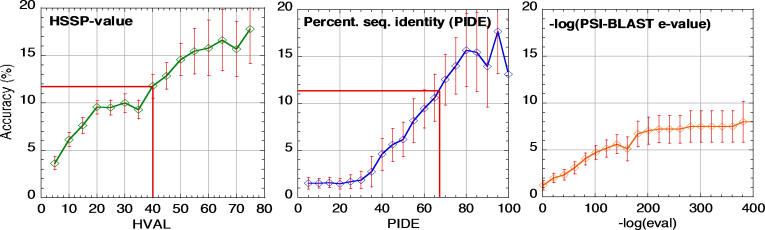
Sequence Conservation of PPIsThe performance of homology transfer was evaluated with the data sets in Experiment 1 (Table 4). Each panel plots the conservation (accuracy of homology transfer) using a different measure for sequence similarity: HVAL (Equation 1), PIDE (percentage pairwise sequence identity), and the PSI-BLAST E-value. It is surprising that even at high similarity thresholds (PIDE > 50; HVAL > 30), accuracy remained low and never reached levels of 20%. This behavior was partially explained by our overlap analysis: for low overlap (Equations 2 and 3) between datasets, we expect a low accuracy. Numbers at HVAL = 40 (which equals a PIDE of 68 at an alignment length of 100 residues) were marked with red lines. HVAL = 40 is the point, where the overlap-values (Equation 3) for two identical datasets seem to indicate a zone of > 70% data consistency (see Table 3). Error bars for the three plots were calculated by bootstrapping over the PPIs in the source datasets (see Methods section).